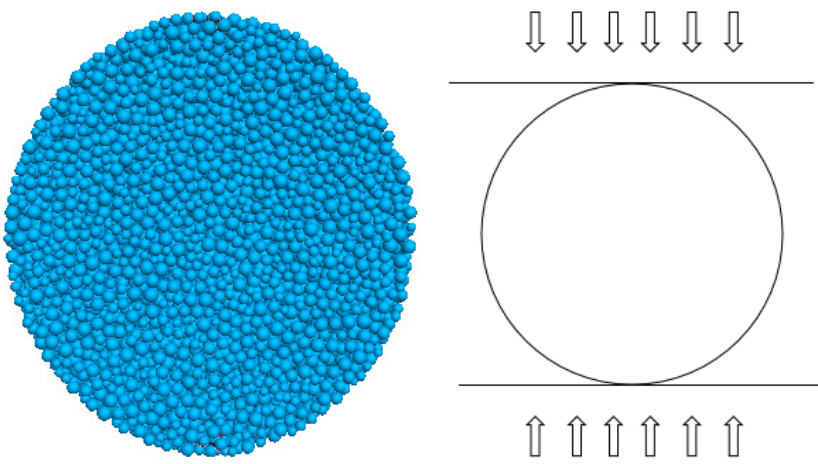
Figure 2. Numerical simulation of Brazilian splitting. The compressive strength of the rock was calibrated utilizing uniaxial compression simulations established by numerical simulation experiments. The dimensions of the numerically simulated specimens are the same as those of the uniaxial compression speci- mens in the chamber, both being cylindrical specimens with a diameter of 50 mm and a height of 100 mm, as shown in Figure 3. The internal friction angle and cohesion of the rock were measured from the indoor triaxial experiments, and the numerical simulations also created cylindrical specimens of the same size as the indoor triaxial specimens, with a diameter of 50 mm and a height of 100 mm. As the triaxial indoor specimens were loaded by confining pressure, the rigid walls that applied the confining pressure were replaced by flexible membrane particles in the numerical simulations, as shown in Figure 4. A linear contact model was used to contact the membrane particles, which better characterises the flexible membrane. The red particles in the middle represent membrane particles, and the blue and green particles above and below represent boundary particles. The right side of Figures 3 and 4 respectively represents the actual loading direction.